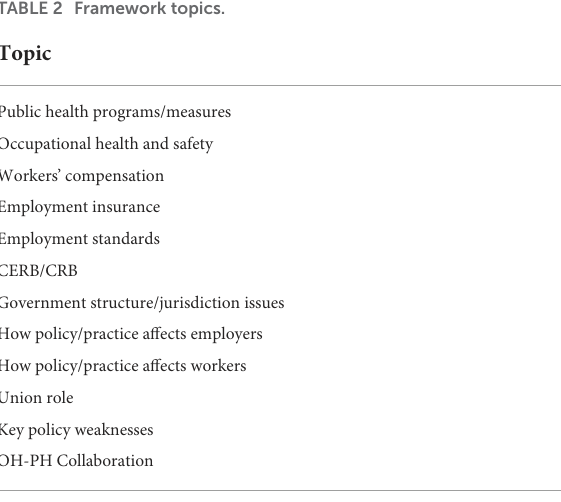
TABLE 2 Framework